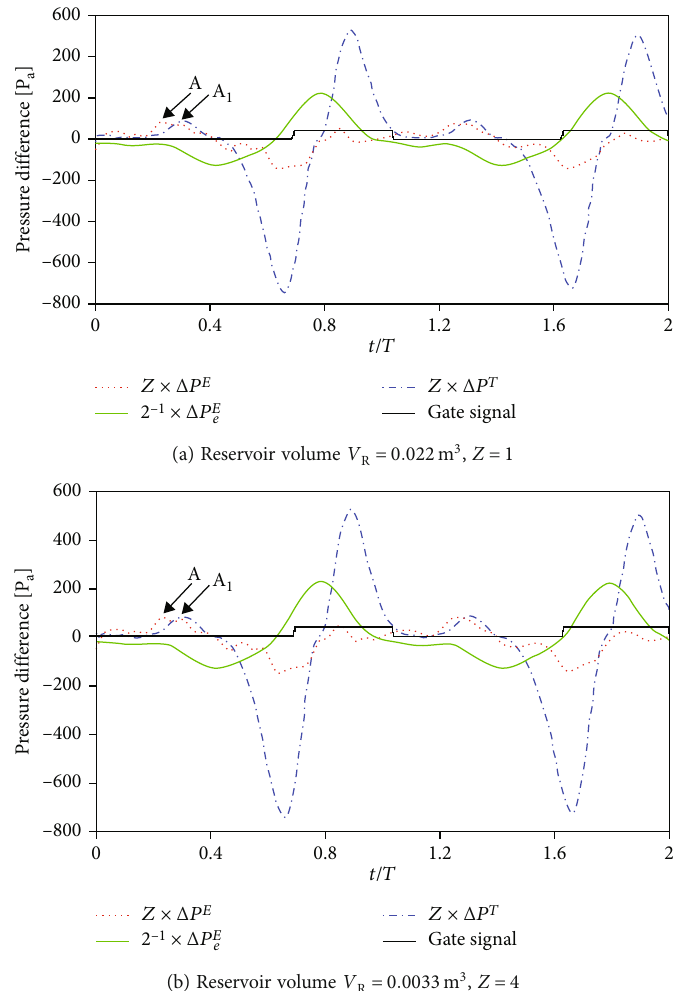
Figure 5: Same as Figure 4, but Z = 10 ; T is the period of a cycle; positive side pressure jumps with a positive pressure loss coe ffi cient, ξ = ξ max